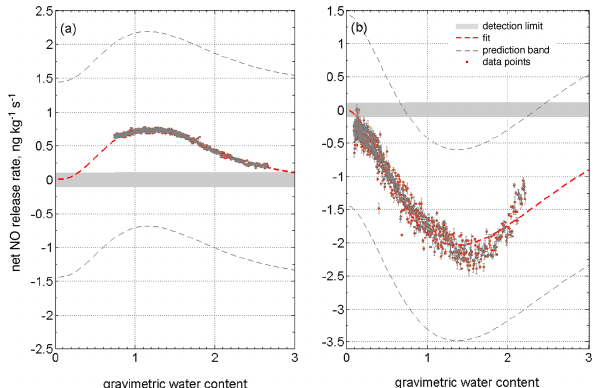
Figure 4. (a) measured net NO release rates (red dots) at m NO,ref =0 ppb and fitted net NO release rates (red dashed line), for a soil samples covered with moss. (b) measured net NO Fig. 4. (a) measured net NO release rates (red dots) at release rates (red dots) at m NO,ref =133 ppb and fitted net NO release rates (red dashed line), for m NO , ref =0ppb and fitted net NO release rates (red dashed line), a moss covered soil. The grey shaded band indicates the detection of the net NO release rate for a soil samples covered with moss. (b) measured net NO release obtained through our laboratory system. Error bars (grey whiskers) on each individual data rates (red dots) at m NO , ref =133ppb and fitted net NO release rates point have been calculated by the Gaussian error propagation (see section 2.10). NO release (red dashed line), for a moss covered soil. The grey shaded band in- dicates the detection of the net NO release rate obtained through our rates in both panels have been obtained for T soil =20°C. laboratory system. Error bars (grey whiskers) on each individual data point have been calculated by the Gaussian error propagation (see Sect. 2.10). NO release rates in both panels have been obtained for T soil =20 ◦